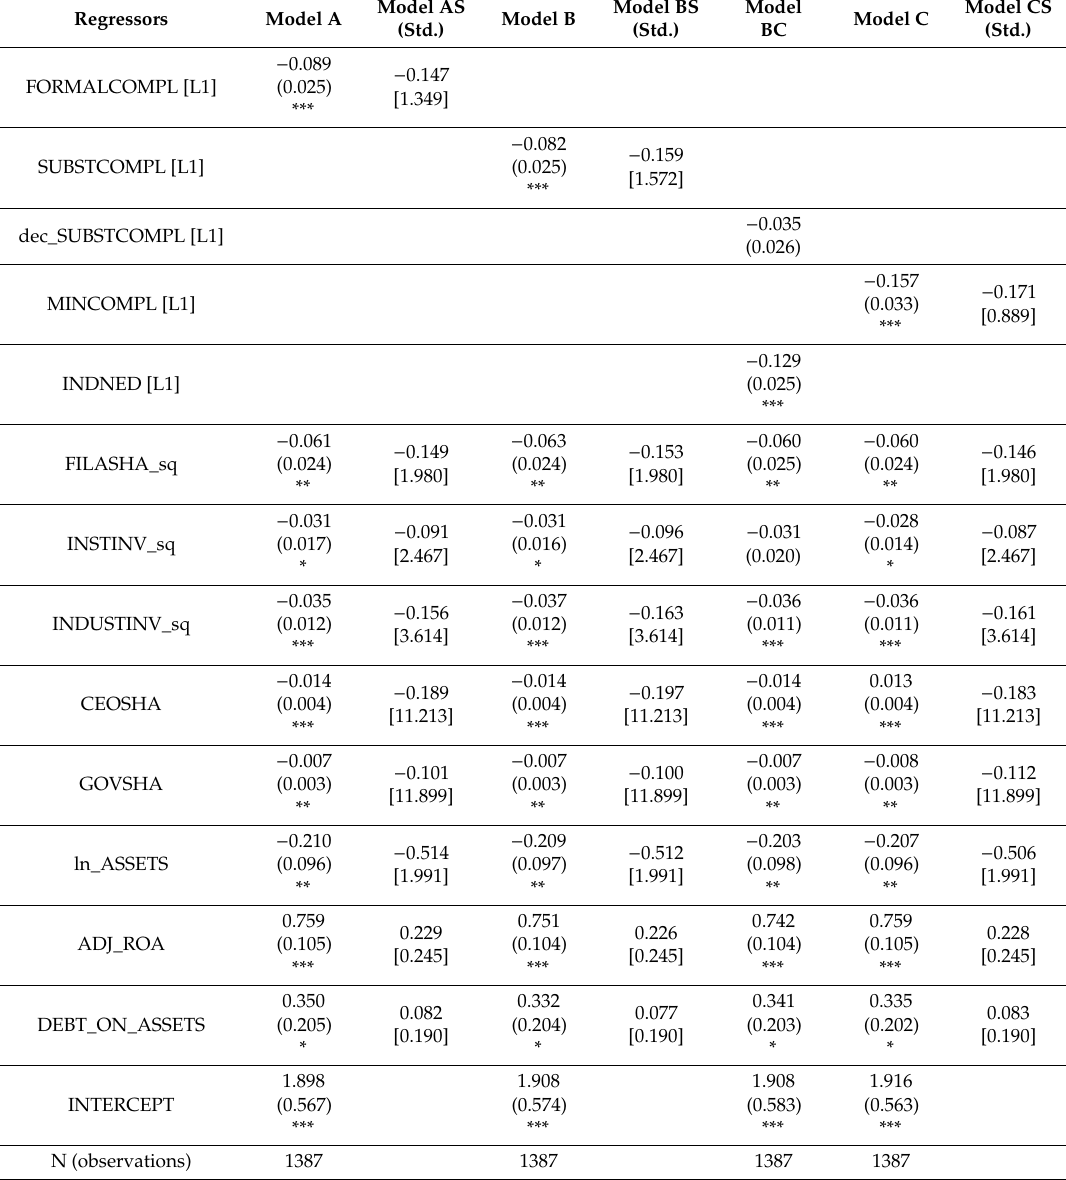
Table 10. Estimation results for dependent